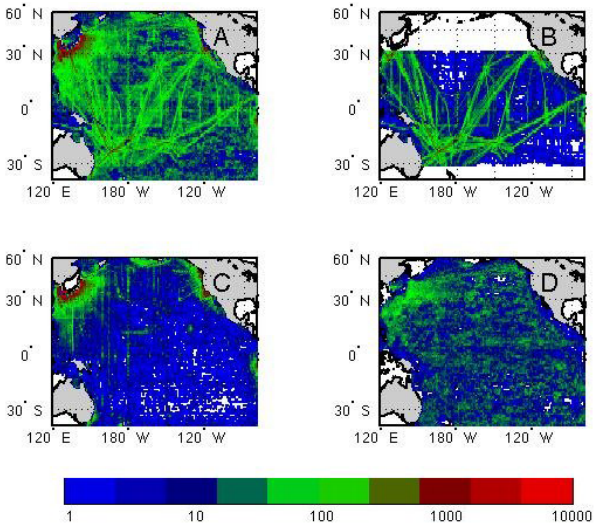
Fig. 1. Spatial distribution of SLS observation density, number of observations/one degree square. Color scale is shown at bottom. (a) All data. (b) Legos Data. (c) OSD data. (d) Argo data. Note color scale is logarithmic. Note also that there was considerable overlap between the original datasets, particularly Legos and OSD. This figure depicts the final data after removal of duplicate measure- ments.